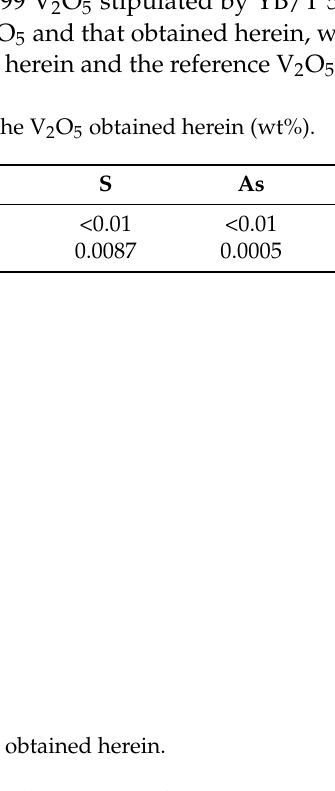
Figure 14. SEM–EDS characterization of V 2 O 5 obtained herein.